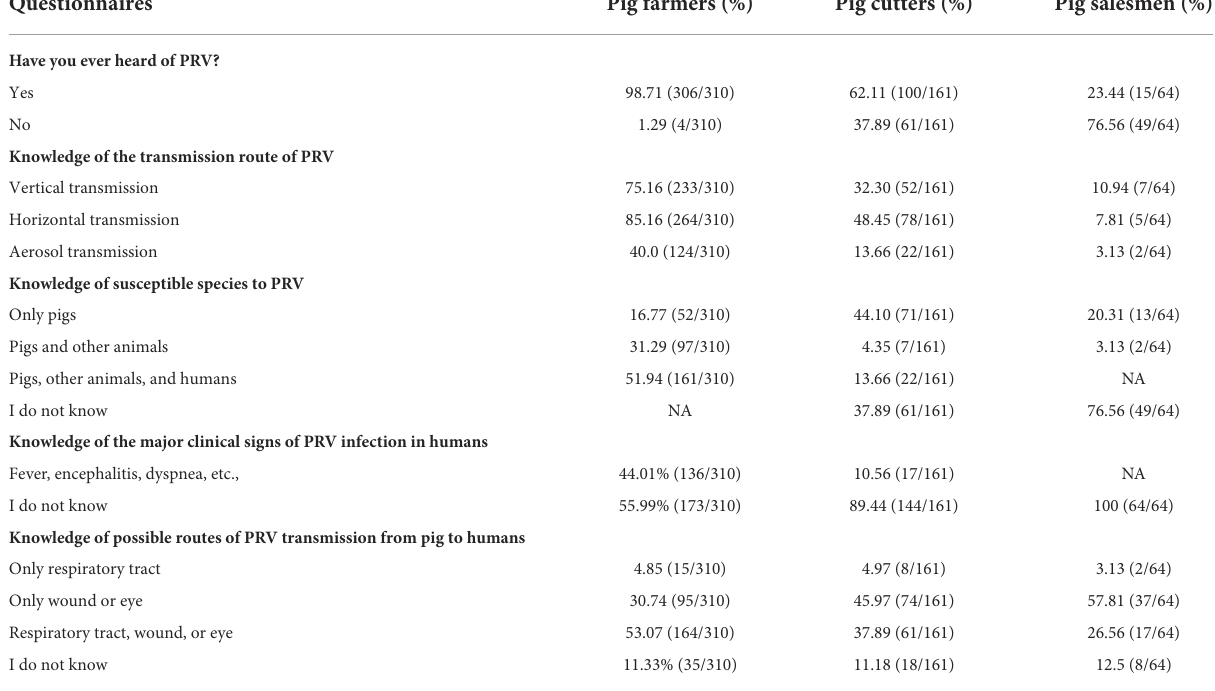
TABLE 2 General knowledge about PRV among pig-related practitioners.